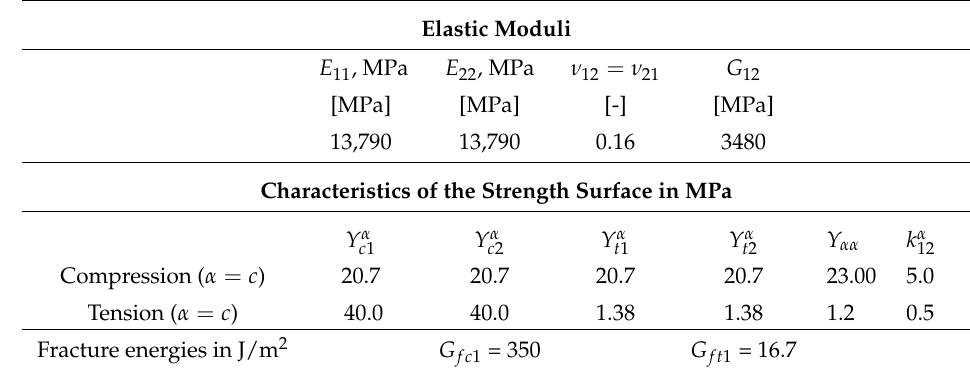
Table 4. Characteristics of materials for orthotropic model of